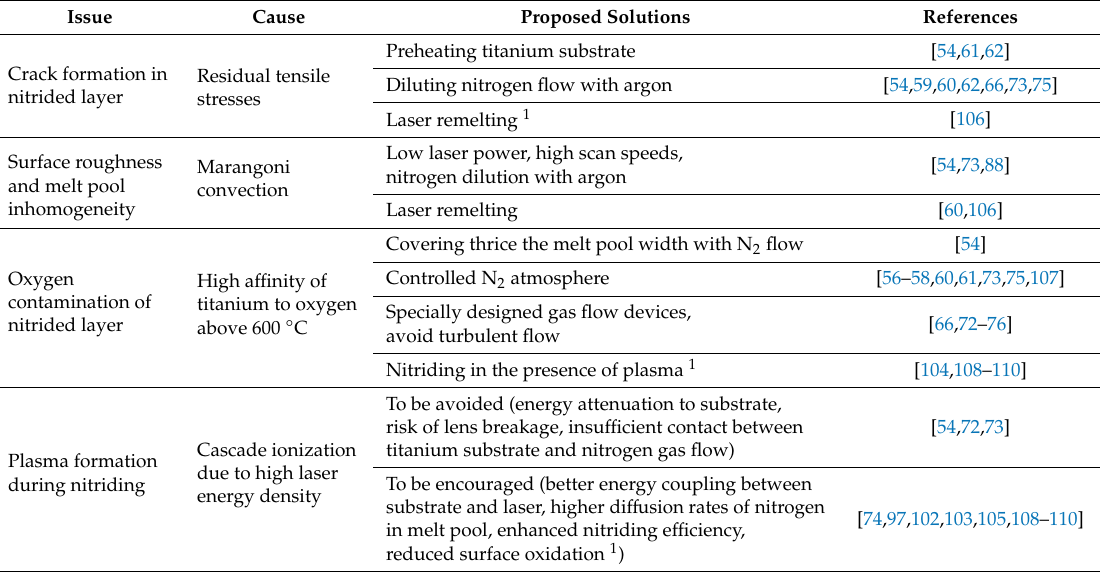
Table 1. Summary of commonly encountered issues in laser nitriding of